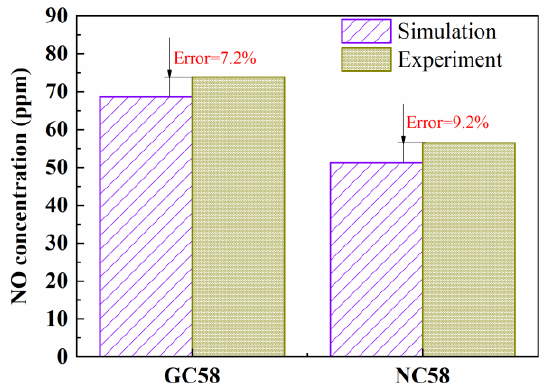
Figure 16. NO concentration at the furnace outlet.